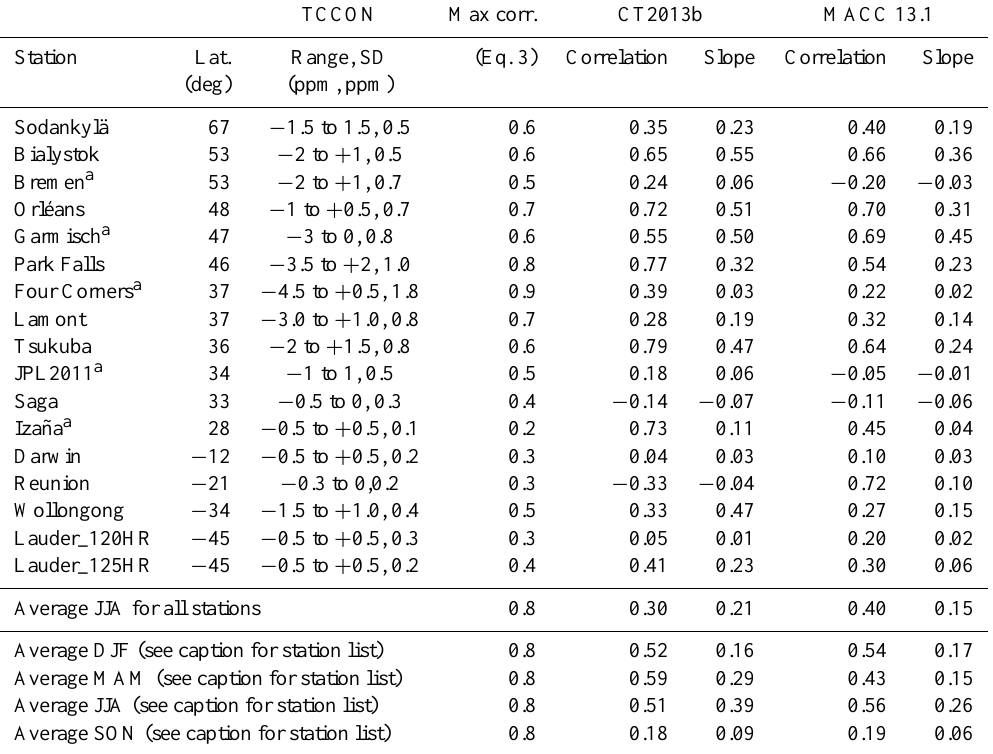
Table 6. Diurnal variability of CT2013b and MACC13.1 vs. TCCON in JJA arranged by latitude. TCCON variability and maximum theo- retical correlation are shown, as well as actual correlation and slope for both models. The slope is the mode vs. TCCON fit to a straight line. a indicates sites expected to be strongly influenced by local sources. Max correlation is calculated using Eq. (3), TCCON SD, and the lower of the model–TCCON standard deviations from Appendix B. TCCON range, SD, shows the range of the values seen for the daily variability for TCCON, as well as the standard deviation of the TCCON daily differences. The average row gives averages for all entries above it. The average rows, e.g., DJF, are for stations Bialystok, Orléans, Park Falls, and Lamont. Eureka and Karlsruhe are not included because fewer than five matches were